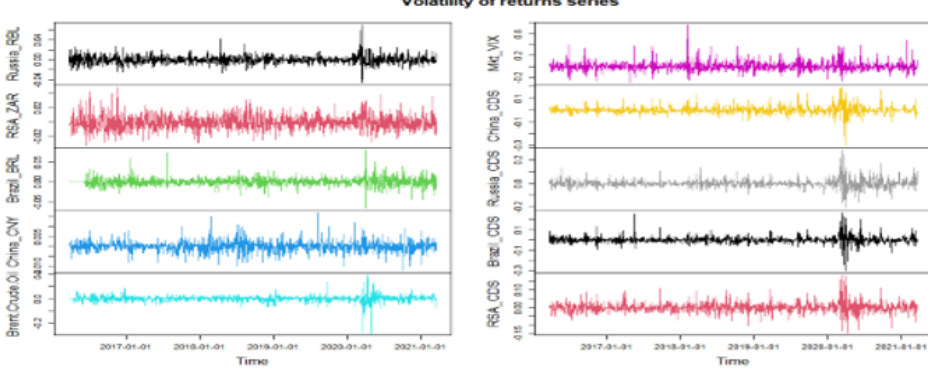
Figure 3. Volatility of returns series, reflecting recursive volatility clusters The GARCH models extracted daily volatility for oil price and exchange rates which